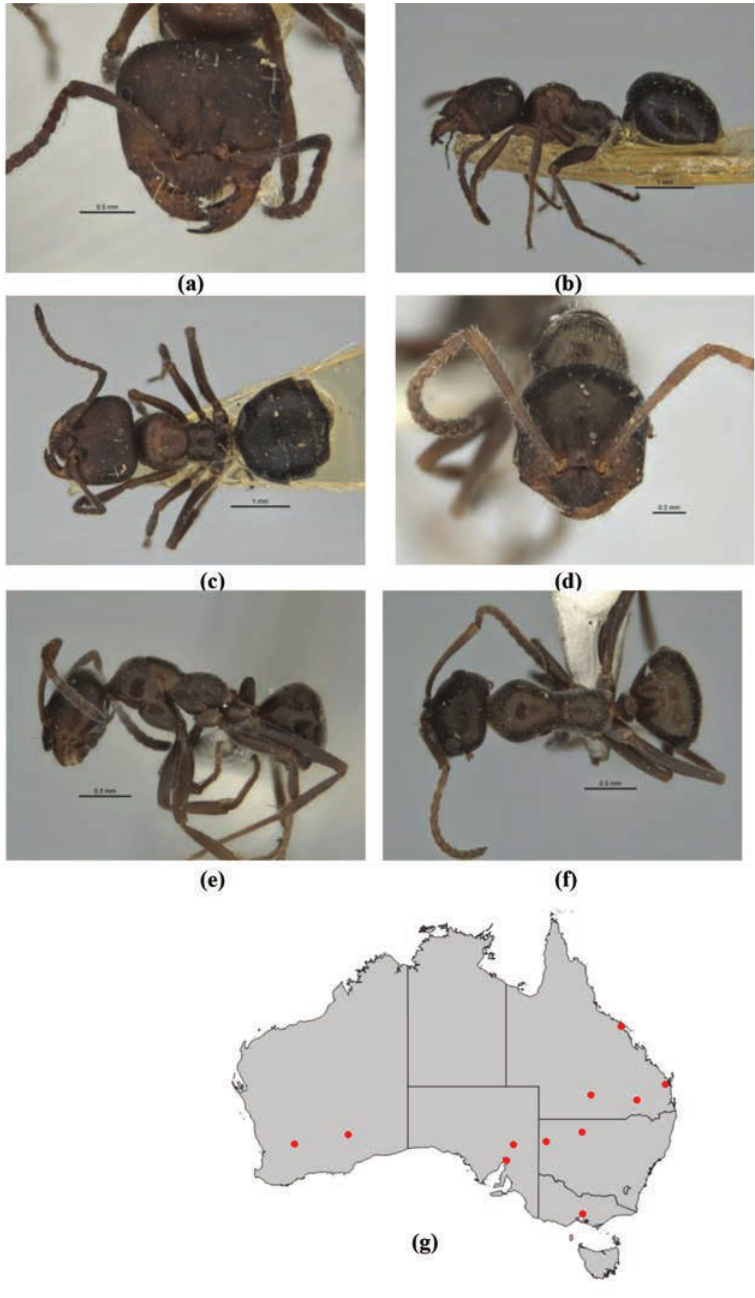
Figure 13. Melophorus gibbosus sp. n.: major worker paratype (ANIC32-900073–second point from top; end ant) frons ( a ), profile ( b ) and dorsum ( c ); minor worker holotype (ANIC32-900031) frons ( d ), profile ( e ) and dorsum ( f ); distribution map for the species ( g ). Low resolution scale bars: 1 mm ( b, c ); 0.5 mm ( a, e–f ); 0.2 ( d